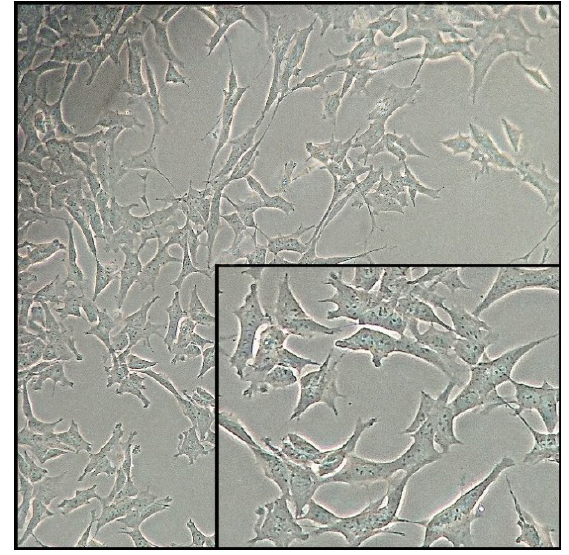
Figure 2. SH-SY5Y cells.